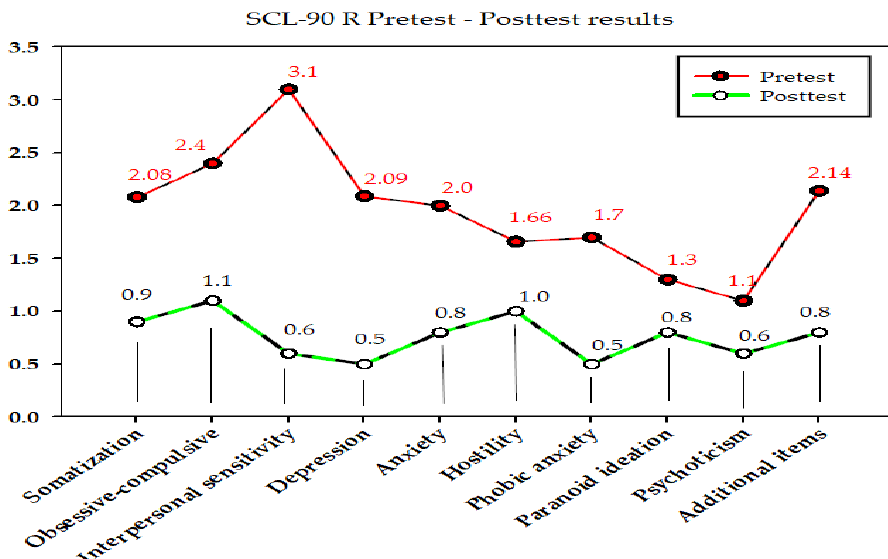
Figure 1. Comparisons of the SCL-90-R pretest-posttest results.